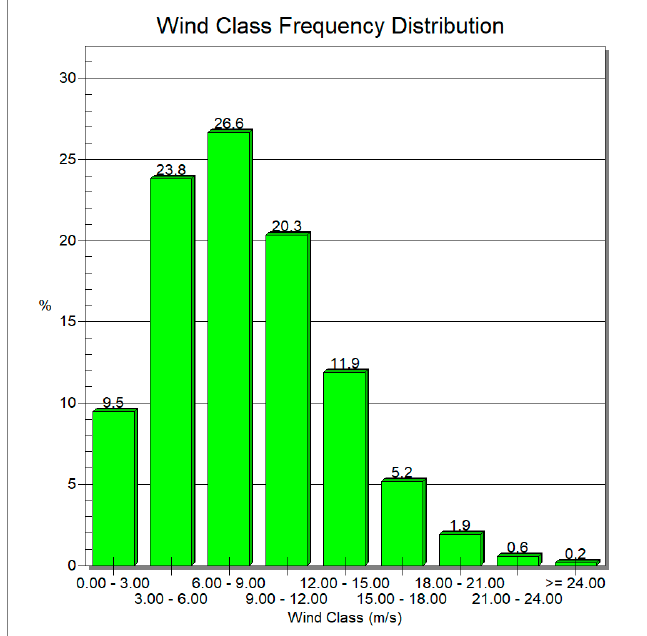
Figure 9. Wind speed frequency distribution at Foveaux site.